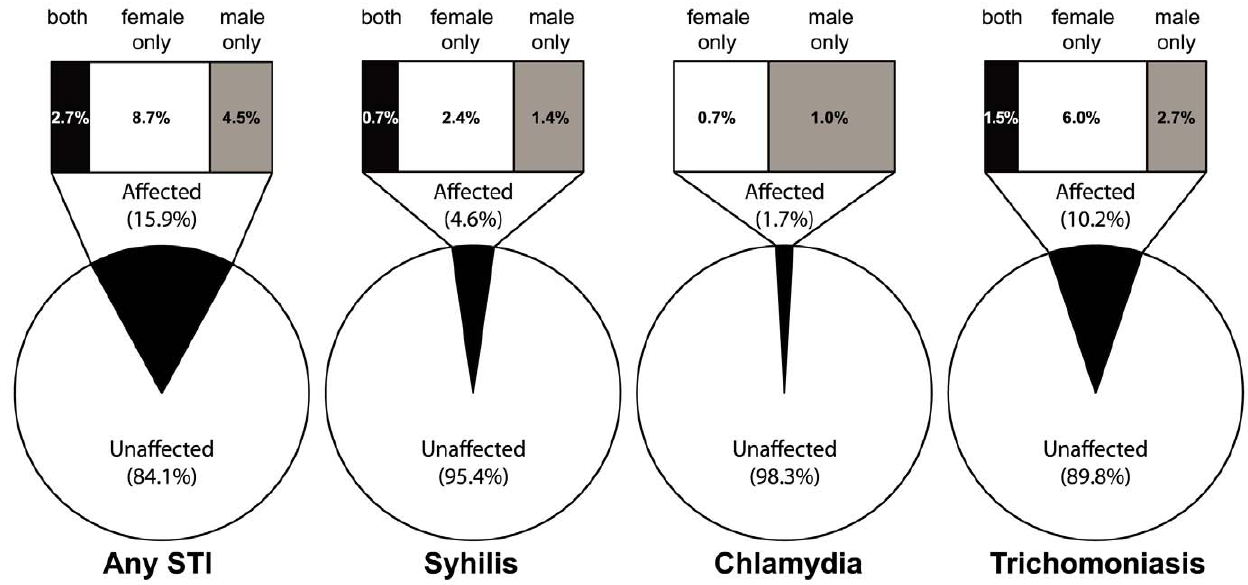
Figure 1. Concordance of treatable STIs identified in female and male partners. Slices of the pie represent the proportion of couples affected and unaffected by an STI. The sections of the upper bar represent the proportion of affected couples in which both partners were infected with an STI, only the female was infected, and only the male was infected. doi:10.1371/journal.pone.0008276.g001 PLoS ONE |